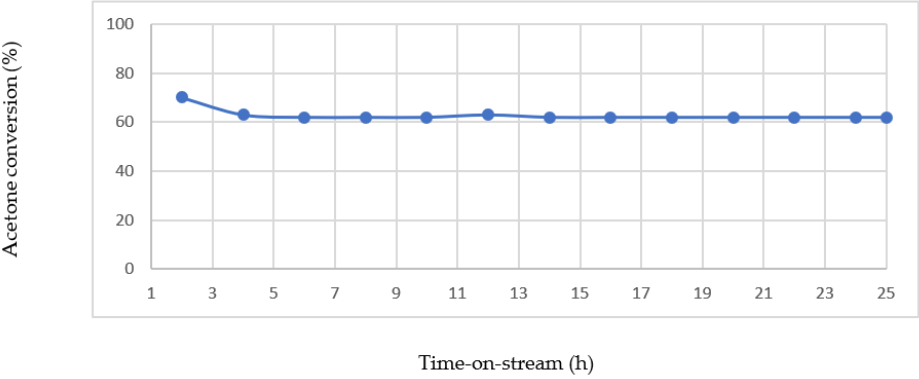
Figure 20. Catalyst lifetime test for as-synthesised Au-0.6M dp/SBA-15 catalyst in acetone complete oxidation at 270 °C .